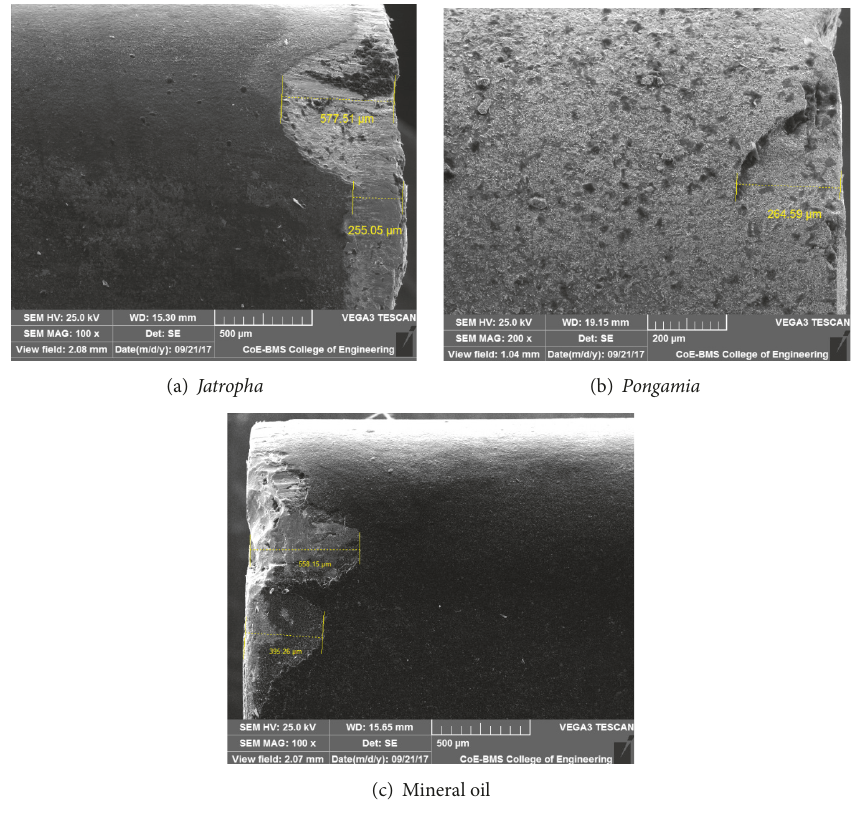
Figure 8: SEM images for flank